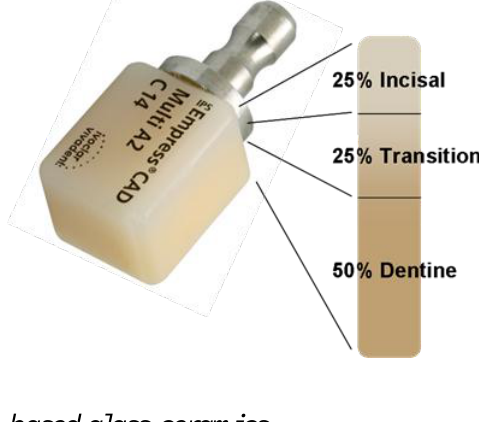
Figure 2. IPS Empress  CAD Multi, Ivoclar Vivadent AG, as multicolor